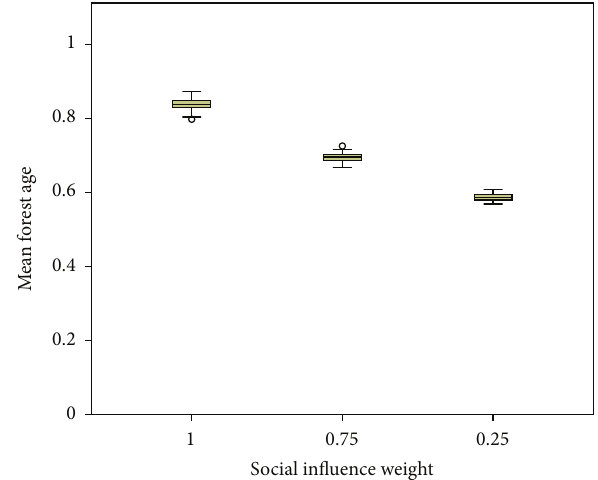
Figure 6: Average forest age (at the landscape scale) increases significantly with an increase in social influence despite high levels of smallholder characteristics that are likely to lead to